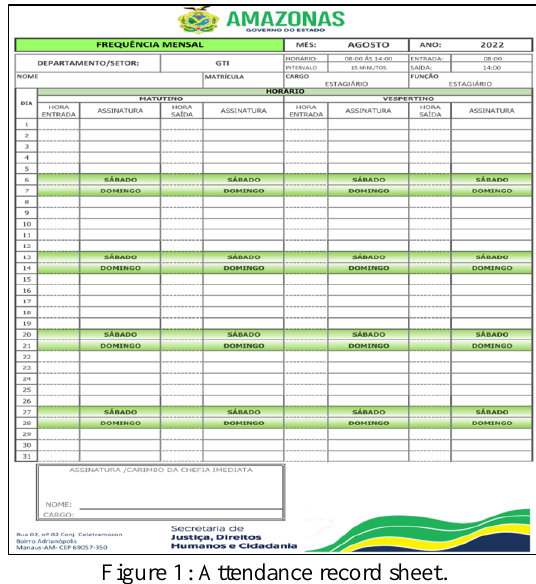
Figure 1: Attendance record sheet.